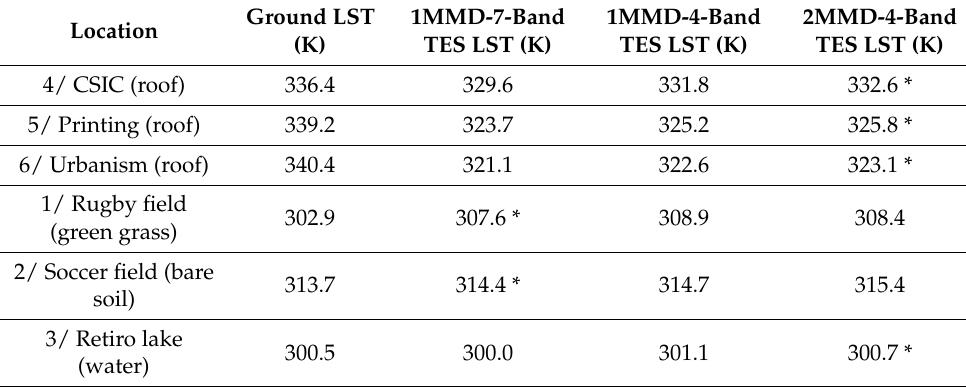
Table 6. LST values for each method and the ground LSTs for the 4 of July 2008 during the daytime. * indicates the retrieved LST closest to the ground measurement.